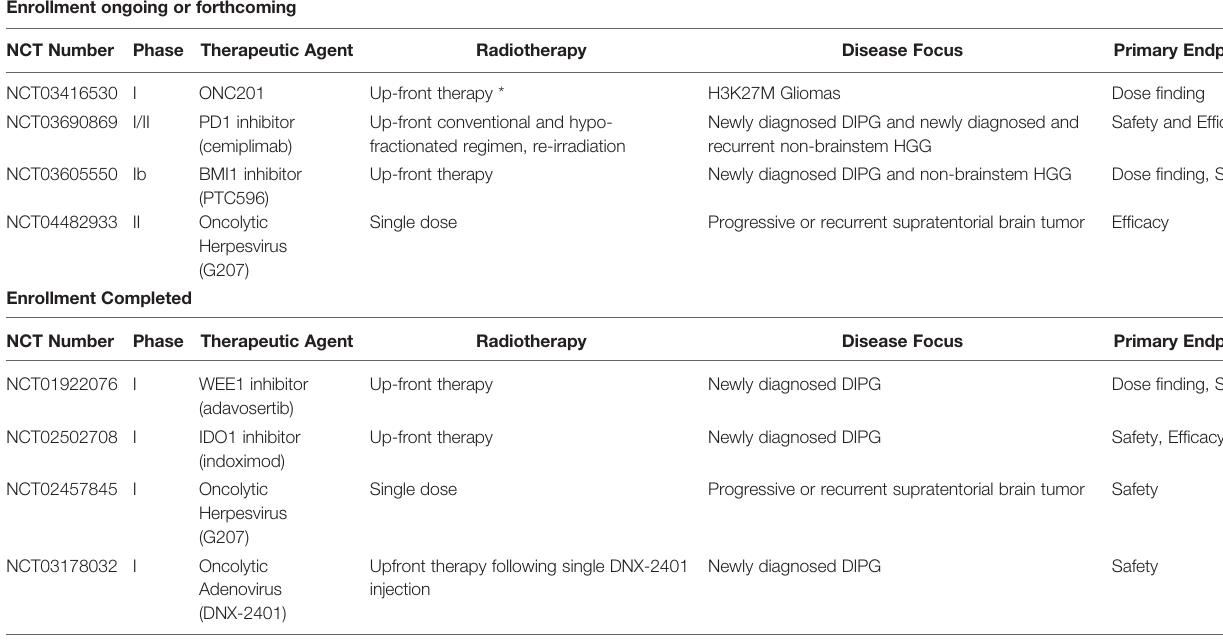
TABLE 1 | Clinical trials evaluating radiation in combination with targeted therapy or